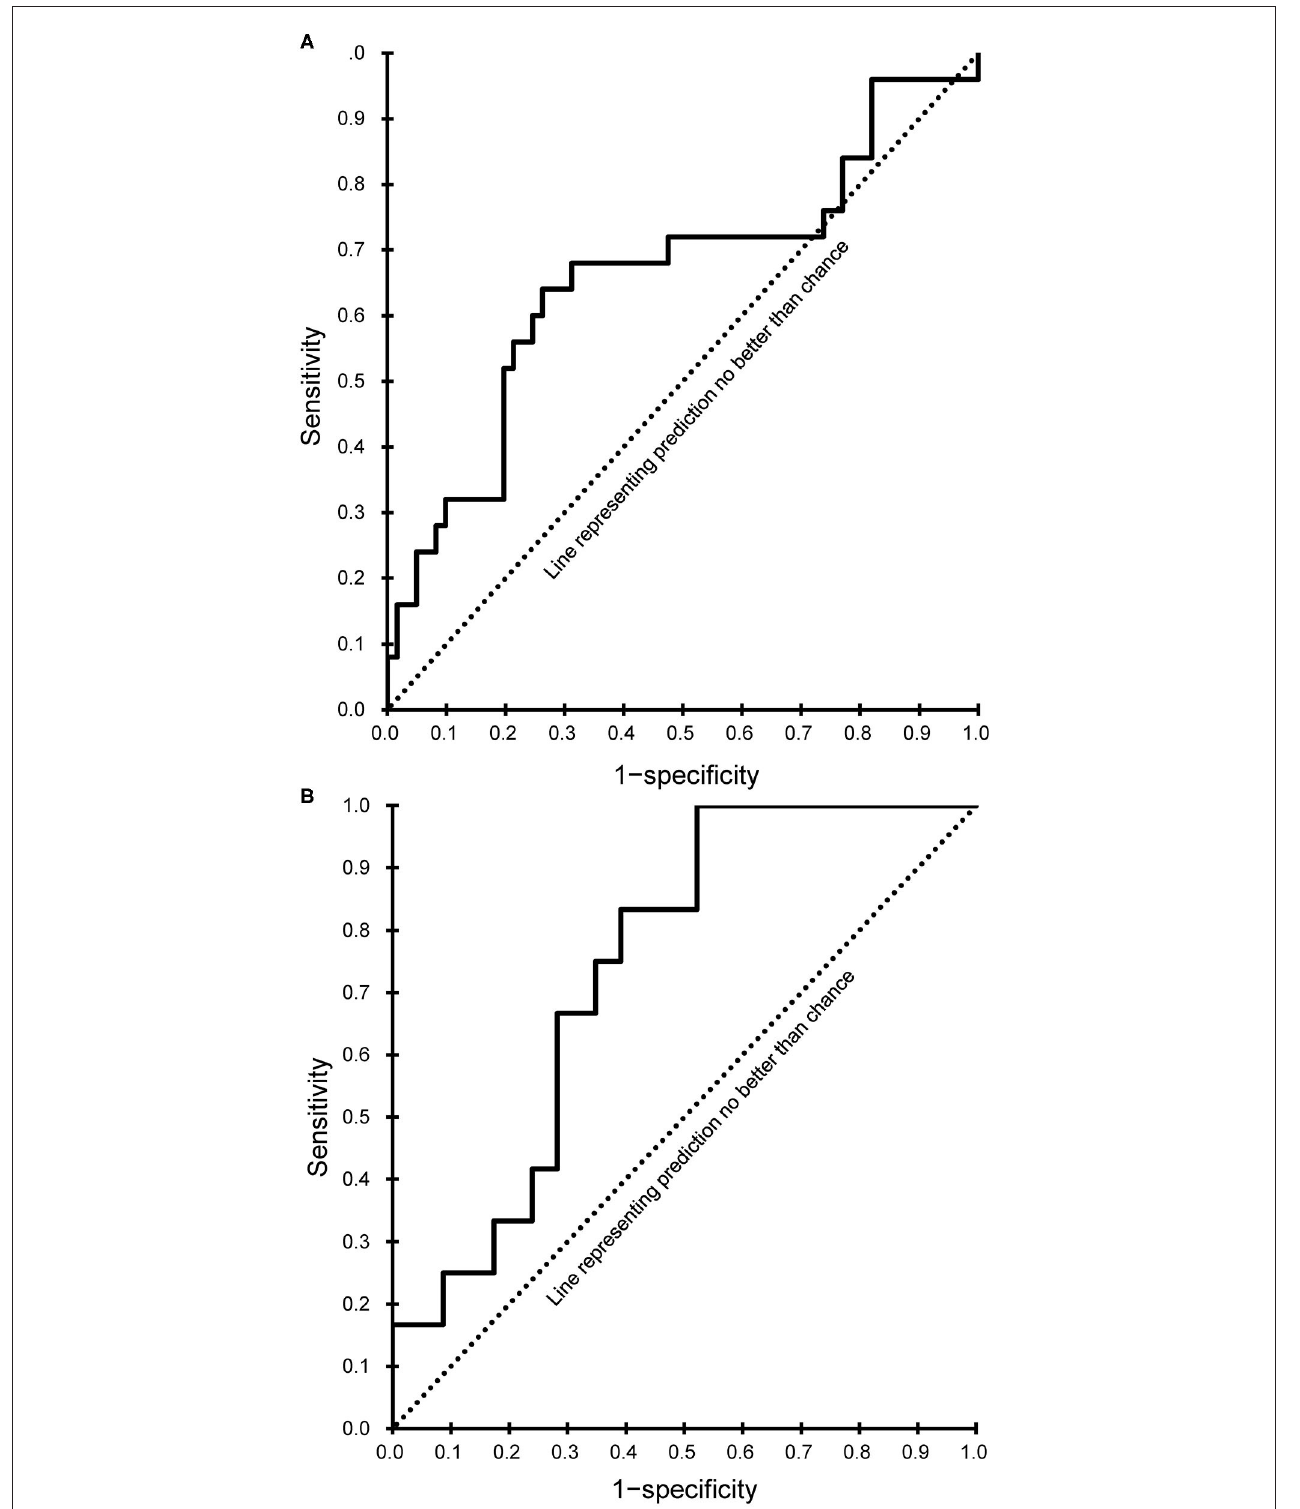
FIGURE 2 | Receiver operating characteristic curves of the final prediction model. (A) Subacute phase. (B) Chronic phase.